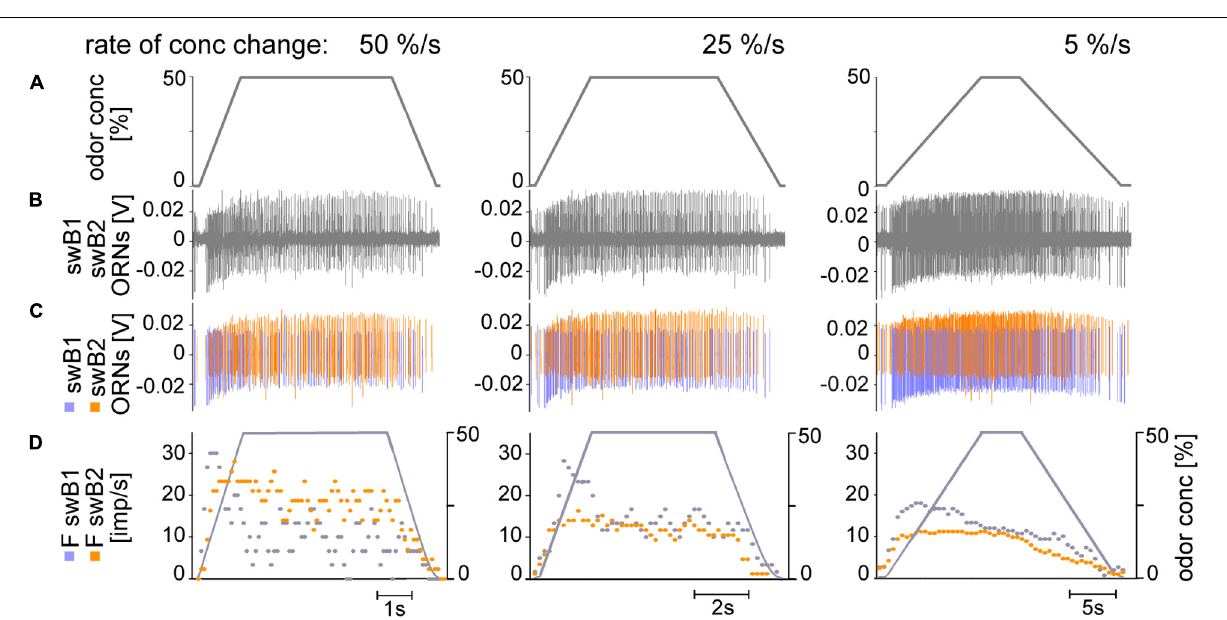
FIGURE 7 | (A–D) Simultaneously recorded responses of two ORNs located in the swB sensillum to ramp-like concentration changes at rates indicated. Ramp rates are 50%/s, 25%/s, and 5%/s. (A) Time course of odor concentration. (B) Extracellular recorded activity; the action potentials from the two ORNs are different